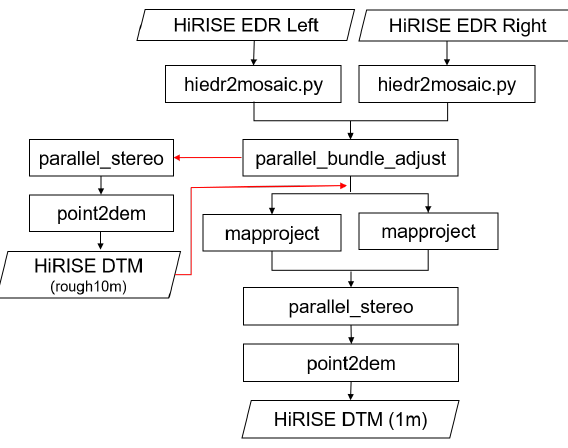
Figure 2. The Flowchart of computing the HiRISE DTM on